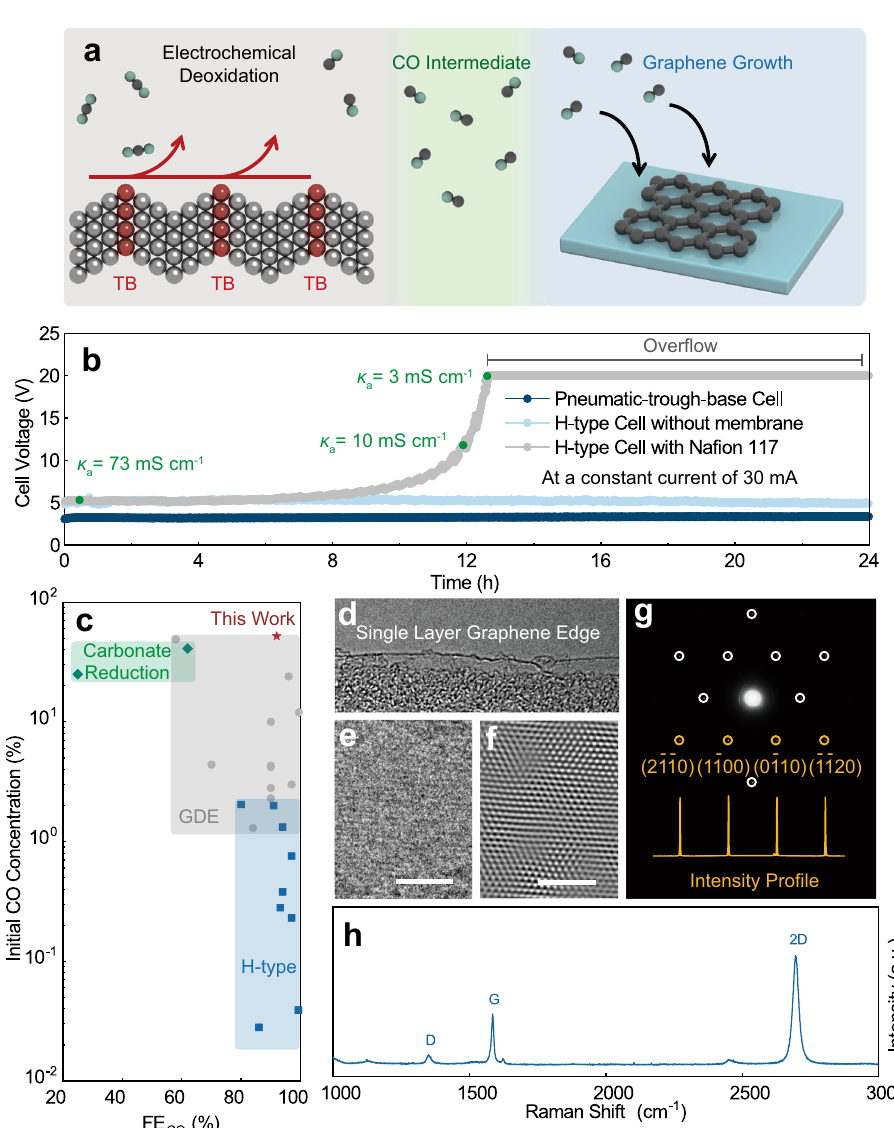
Fig. 3 Tandem system for graphene synthesis. a The schematic diagram of “ two-step ” synthesis of graphene from CO 2 . b Cell voltages at a constant current density of 30 mA cm − 2 in pneumatic-trough-based cell and H-type cell with/without Na fi on 117 membrane. The area of the electrode is ~1 cm 2 . The “ over fl ow ” represents the applied voltage reaches the maximum of our electrochemical workstation (20 V). The κ a represents the electric conductivity of anolyte. c The literature summary of FE CO and initial CO concentration 21 – 38,40,41 . The red, green, gray, and blue spots represent the results of this work, carbonate reduction systems, GDE systems, and H-type cell systems, respectively. d The TEM image of graphene fi lm edge (scale bar: 10 nm) The e raw and f FFT-treated HRTEM images of graphene fi lm lattice (scale bar: 2 nm). g The SAED pattern of graphene fi lm and the intensity pro fi le of diffraction spots along (2110), (1100), (0110), and (1120) facet. h Raman spectrum of graphene fi